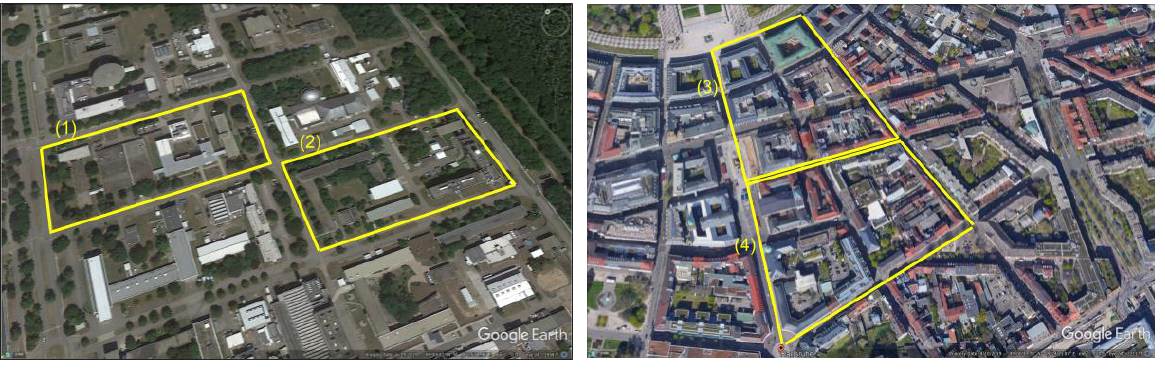
Figure 2. Illustration of the experiment locations.